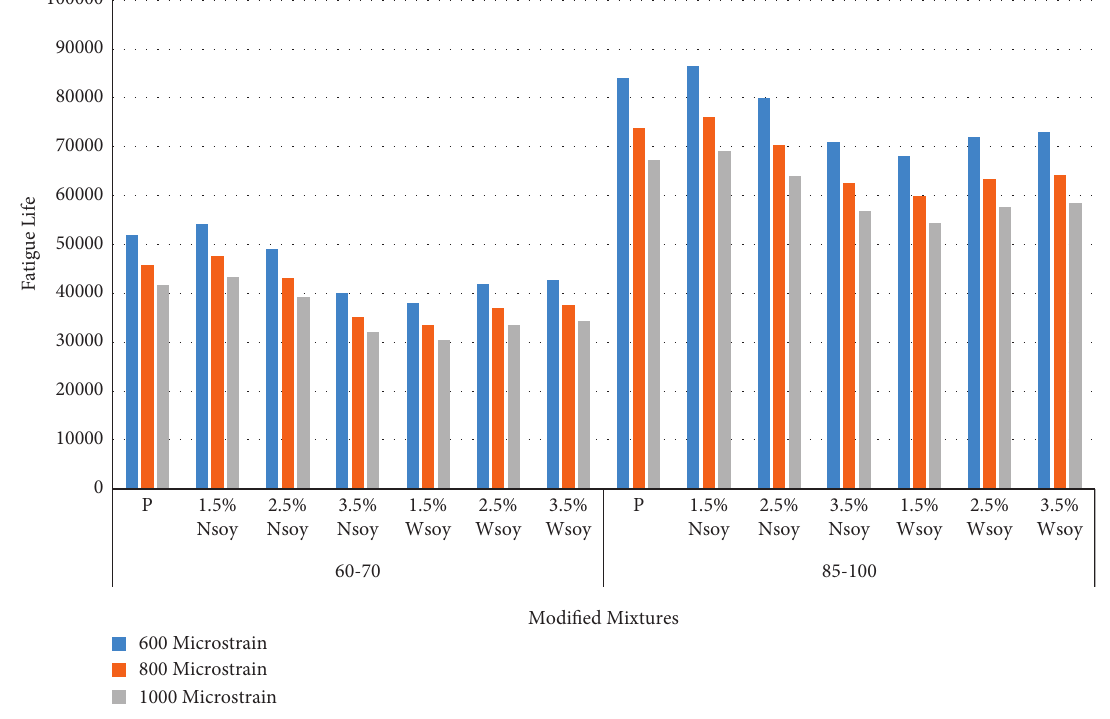
Figure 12: Unmodified and modified mixtures’ fatigue lives.